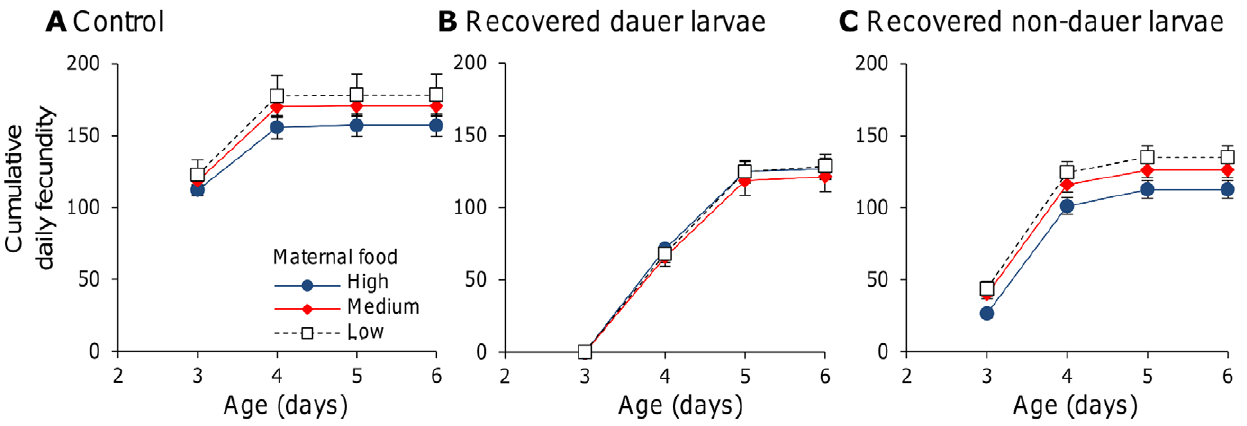
Figure 4. Effects of maternal condition depend on progeny environment. The mean cumulative daily fecundity at 25 u C of (A) control, ad libitum food, progeny, (B) recovered dauer larvae progeny and (C) recovered non-dauer larvae progeny of mothers from a range of maternal food concentrations. Recovered dauer and non-dauer larvae were isolated from a standard dauer larvae assay prior to the onset of reproduction. High maternal food availability was 10% w/v E. coli , Medium maternal food availability was 2.5% w/v E. coli and Low maternal food availability was 1.25% w/v E. coli . Fecundities were calculated from at least 16 hermaphrodites (range 16–40, mean of 24.2). Error bars are 6 1 standard error.